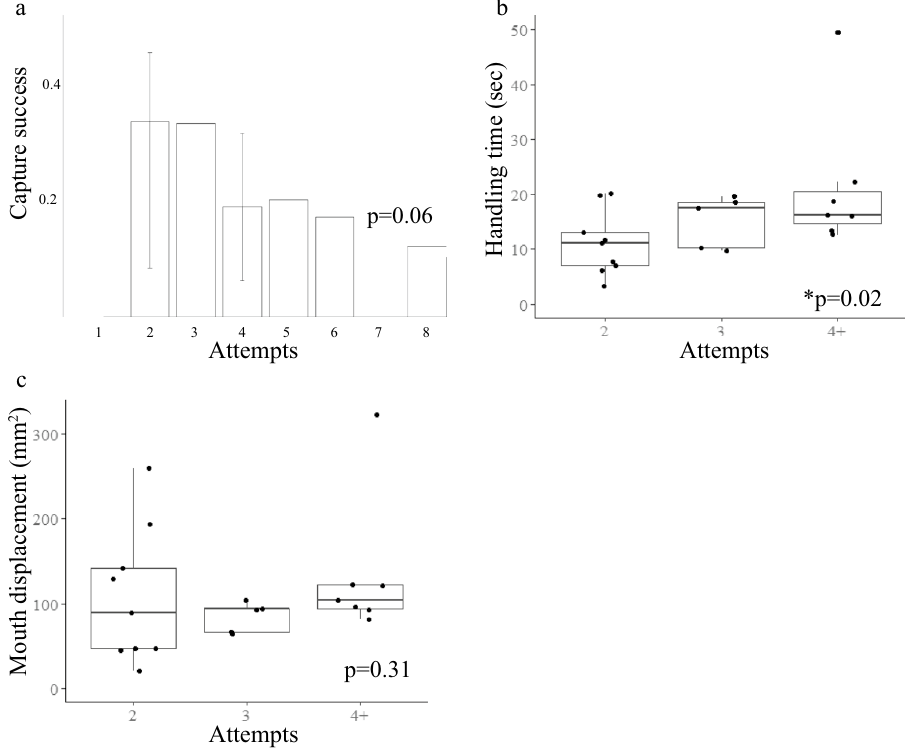
Figure 5. Interactions with multiple copepods and the relationship between number of attempts taken in one encounter and ( a ) capture success rate ( p = 0.06, rho = − 0.42); values on the x-axis without error bars represent a number of attempts that was seen in only one encounter, ( b ) handling time ( p = 0.02, rho = 0.50), and ( c ) total mouth displacement ( p = 0.31, rho = 0.23). Thick horizontal lines within each box show median values, vertical lines on either side of each box show standard error, dots represent individual data